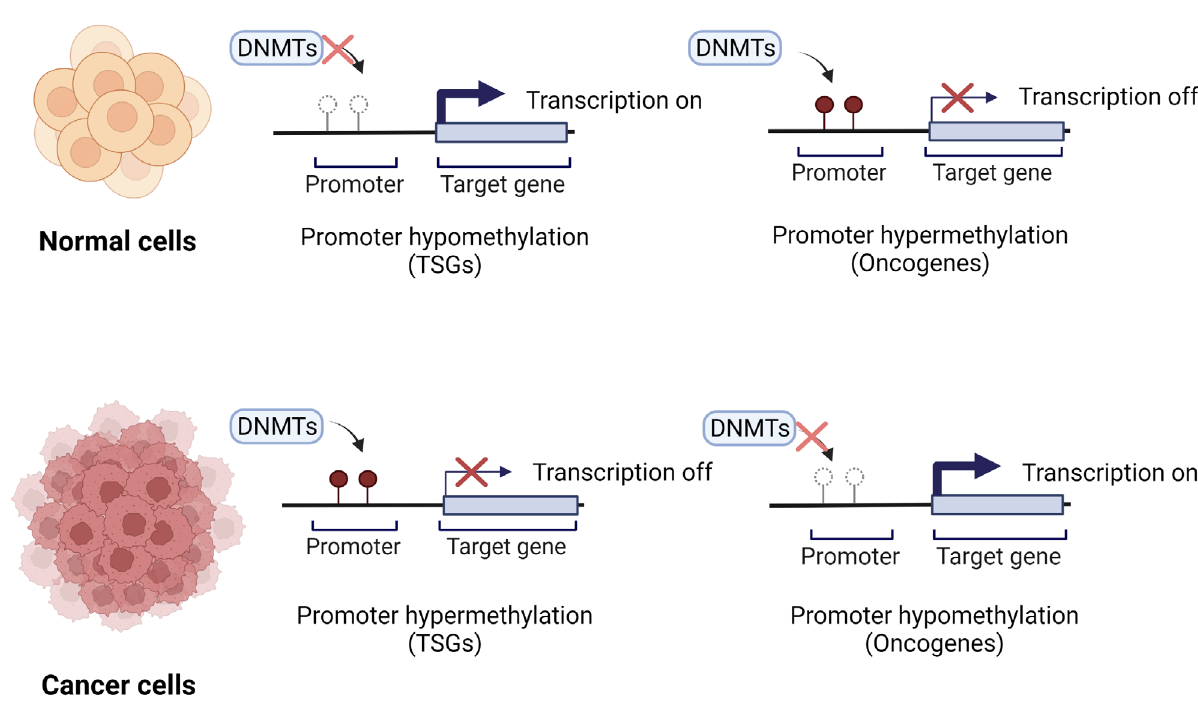
Figure 2 – DNA methylation pattern in different cell types. In normal cells, the promoter regions of tumor suppressor genes (TSGs), as cell cycle regulators, are hypomethylated; meanwhile, in oncogenes (as transcription factors), this same region is frequently hypermethylated by DNA methyltransferases (DNMTs). On the other hand, an opposite pattern is described in cancer cells, with TSGs being hypermethylated, while oncogenes present a hypomethylated promoter region. Adapted from “Epigenetic deregulation in cancer”, by BioRender.com (2022). Retrieved from